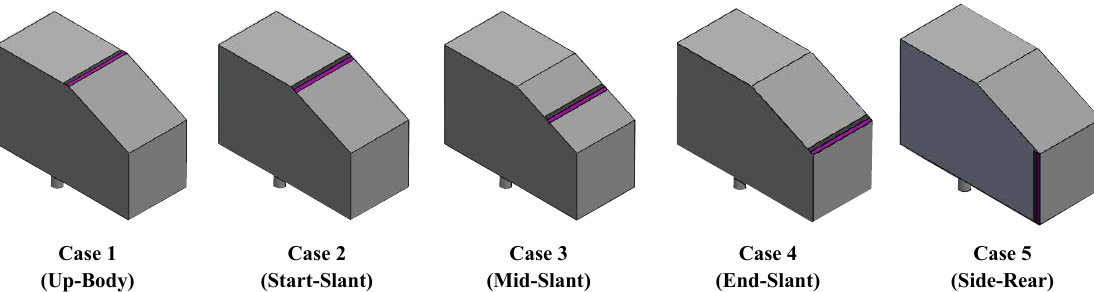
Figure 6. Different locations of single dielectric barrier discharge (SDBD) on the surface of the Ahmed